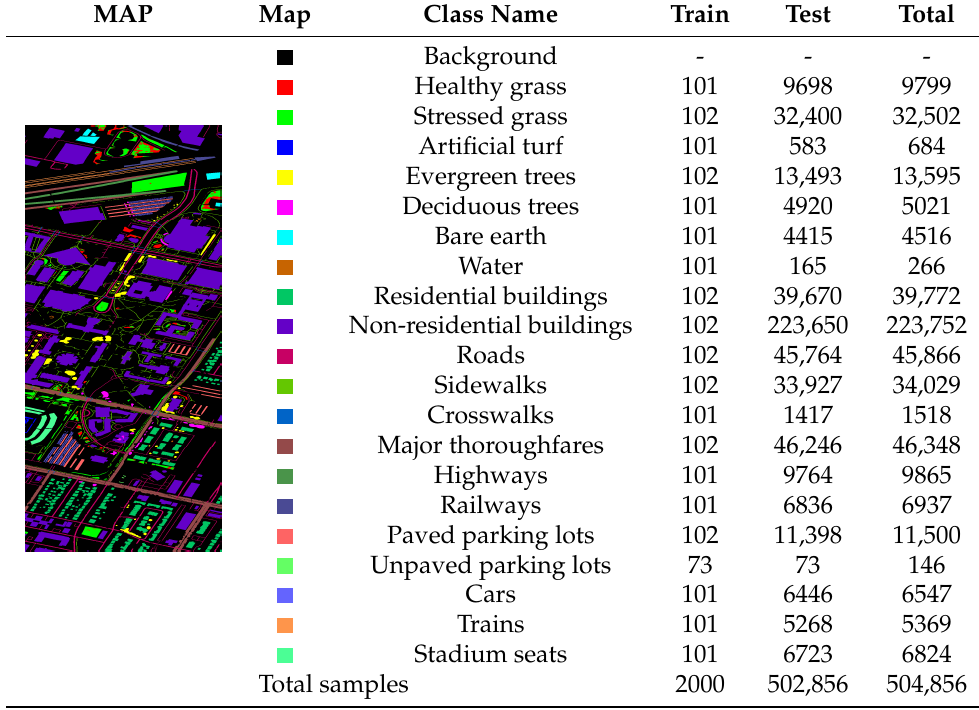
Table 2. Sample labels and sample size for the University of Houston dataset.